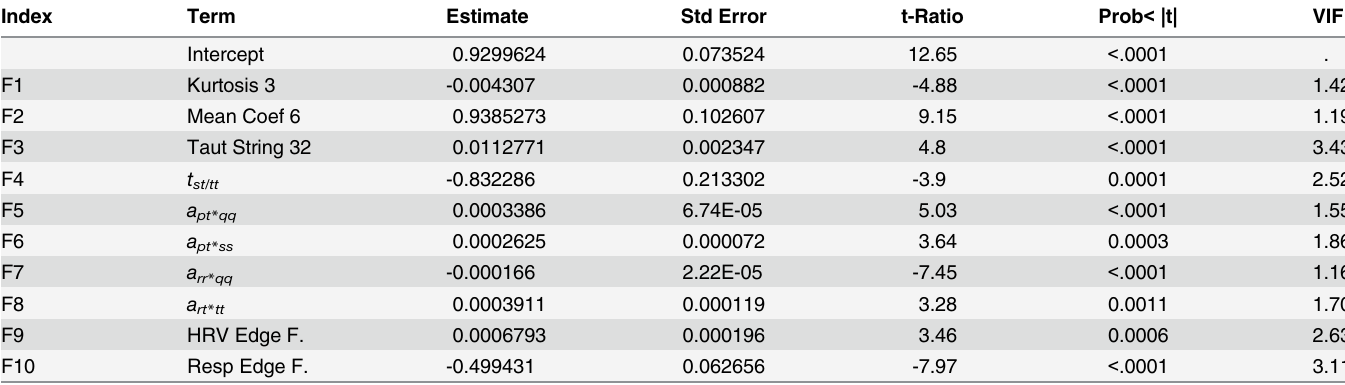
Table 1. Table of selected features.